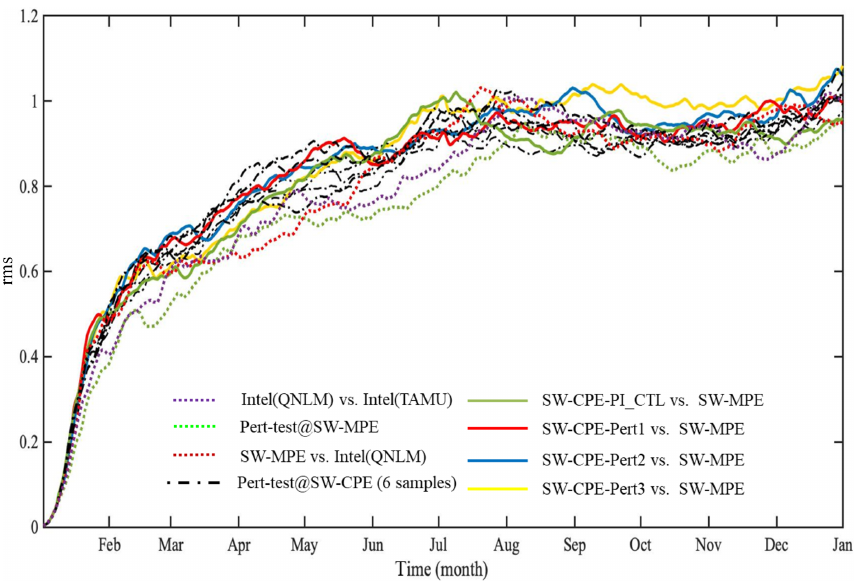
Figure 10. Time series of the root mean square (rms) global SST differences between each of the three perturbation and PI_CTL simulations of the CESM-HR SW-CPE version and the CESM-HR SW-MPE simulation (four solid coloured lines) and any two of the four CESM-HR SW-CPE simulations (each pair of simulations produces a black dashed-dotted line so the total is six black dashed-dotted lines). Time series of rms global SST differences shown in Fig. 6 between the Intel(QNLM) and Intel(TAMU) (purple dotted), and two perturbed SW-MPE simulations (green dotted) as well as the SW-MPE and Intel(QNLM) (red dotted) are also plotted as the reference.